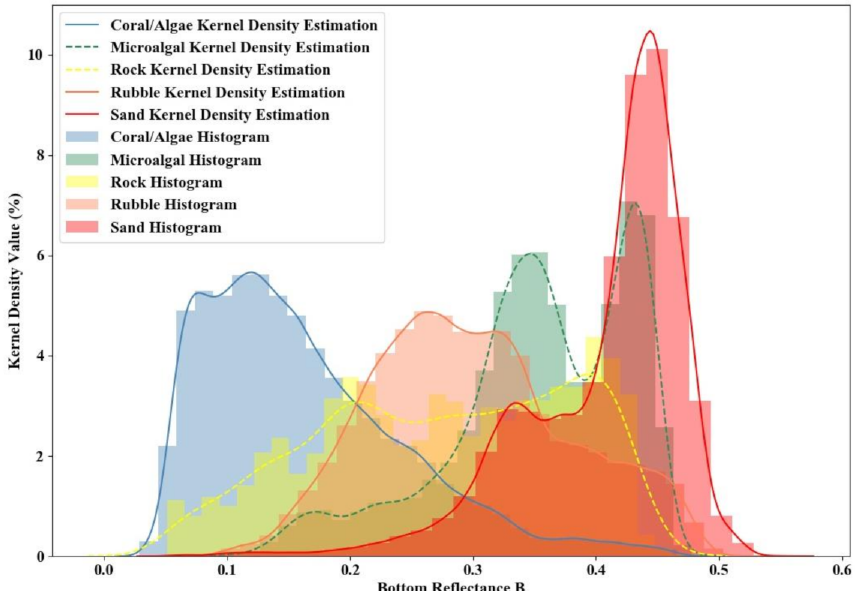
Figure 12. Histograms and kernel density estimation curves of the bottom reflectance at 550 nm corresponding to coral/algae, rubble, and sand,